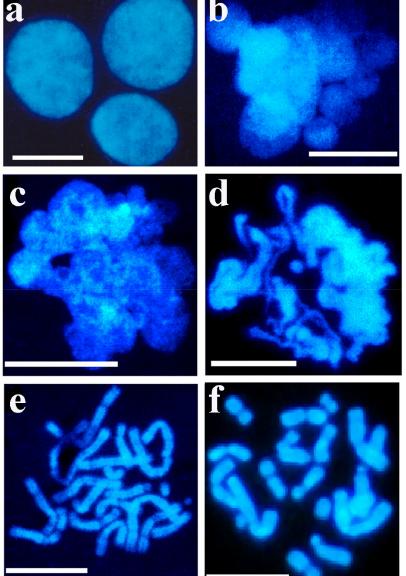
Figure 4. Isolation of interphase and metaphase chromosomes from exponentially growing CHO cells. A 30 min pulse-label of nascent DNA in permeable cells in the presence of the four dNTPs was followed by the reversal of permeabilization. Cells were kept at 37 ◦ C for 3 h and then treated with 0.1 µ g/mL Colcemid. After further incubation (2 h at 37 ◦ C), cells were detached with trypsin and washed with PBS. Swollen cells were centrifuged at room temperature (800 × g for 5 min), and fixed in 10 mL methanol: glacial acid (3:1). Preparation of spreads of metaphase chromosomes was the same as that of interphase nuclei. The reversible permeabilization of cells, isolation and visualization of chromatin and chromosome structures were described in the Methods. ( a ) Control nuclei isolated from reversible permeable cells, ( b ) metaphase chromosomes, ( c ) nuclear ribbon-forming loops, ( d ) chromatin loops turning to chromosomes, ( e ) bent, elongated chromosomes and ( f ) metaphase chromosomes. Bars, 5 µ m each. Modified with permission from Ref. [84]. Copyright year 2014, Apoptosis in Figure 4 of this